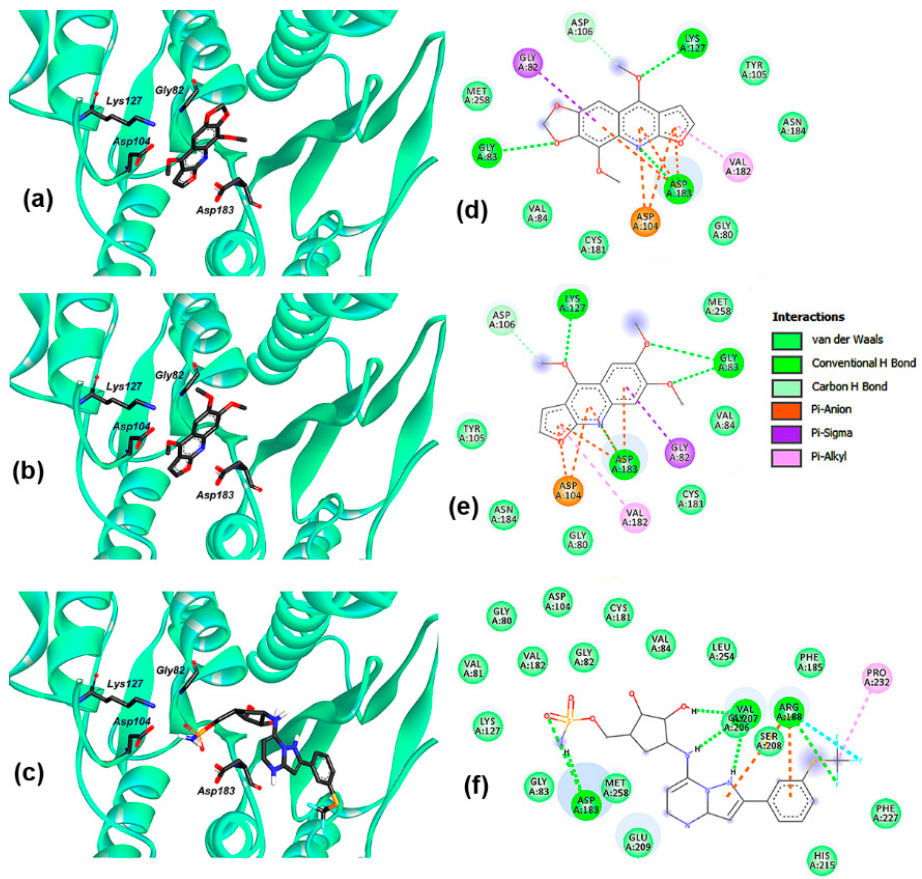
Figure 2. Interaction between test alkaloids 1 – 2 and inhibitor TAK-243 within the binding site of ubiquitin-like modifier-activating enzyme 5 (UBA5). 3D diagrams for ( a ) 1 ; ( b ) 2 ; ( c ) TAK-243 in complex with UBA5. 2D residual interaction diagrams for ( d ) 1 ; ( e ) 2 ; ( f ) TAK-243 in complex with UBA5. The different types of interactions between ligand and enzyme residues are exposed with different color according to the interactions panel.